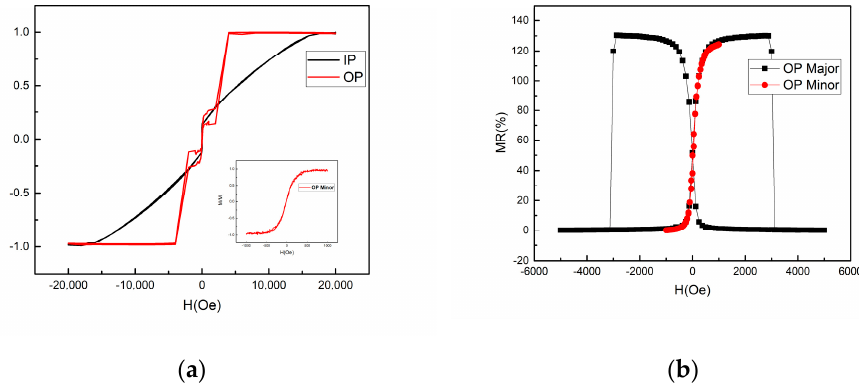
Figure 6. ( a ) The in-plane (IP) and out-of-plane (OP) hysteresis loops of the full-stack MTJ film after annealing. The inset shows the out-of-plane minor loop. The lower saturation magnetization in the IP loop is caused by the unsaturated SAF under 1.5 T in-plane magnetic field. ( b ) The RH transfer curves of the MTJ. The black (red) curve is the major (minor) RH